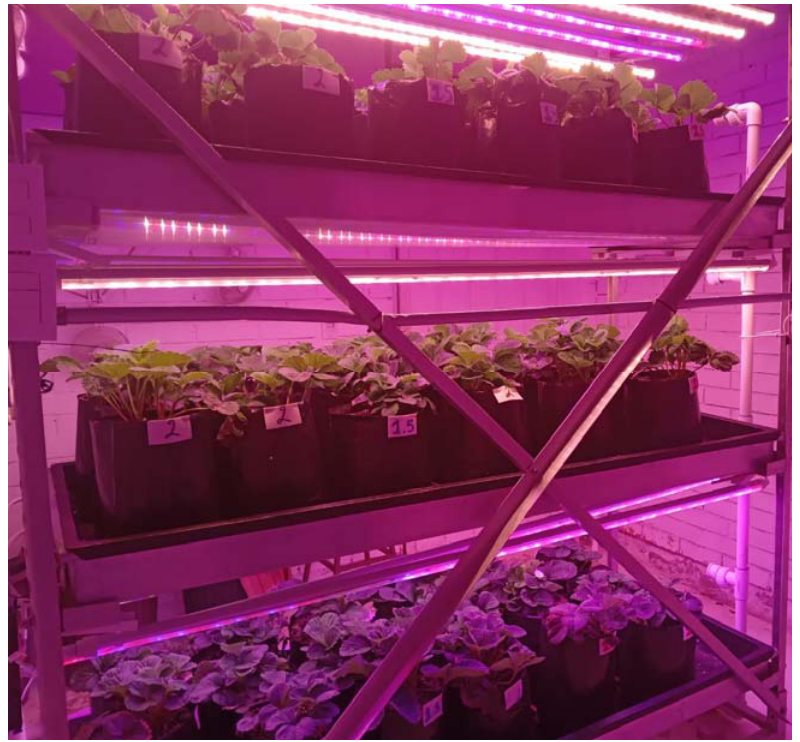
Figure 1. The vertical farming rack used for the experiment to assess the green and blue light balance in strawberry plants.